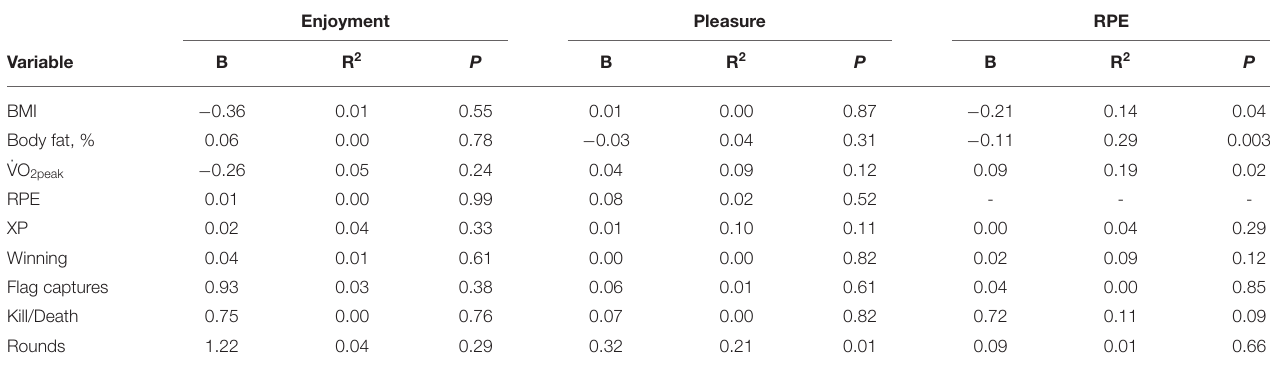
TABLE 4 | Regression analyses for enjoyment, pleasure, and rating of perceived exertion (RPE) during exergaming. Enjoyment Pleasure